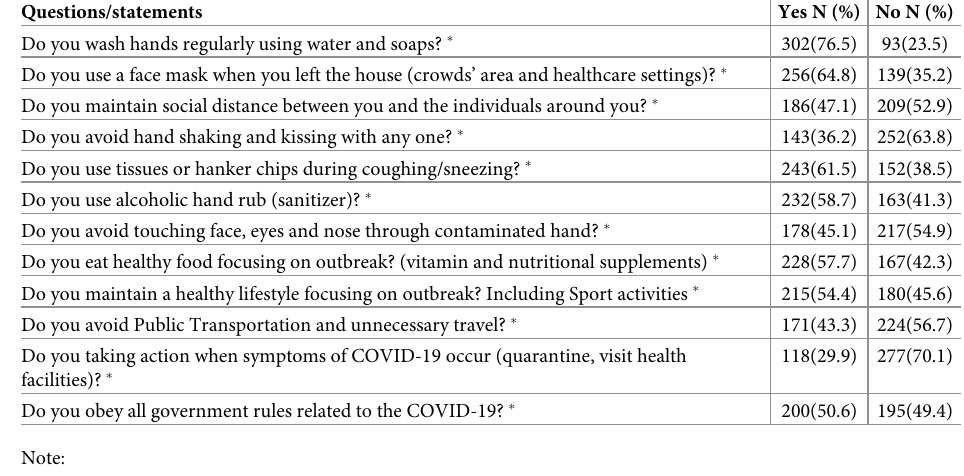
Table 4. Preventive practice of secondary school students towards COVID-19 in Gondar town, Northwest Ethio- pia,